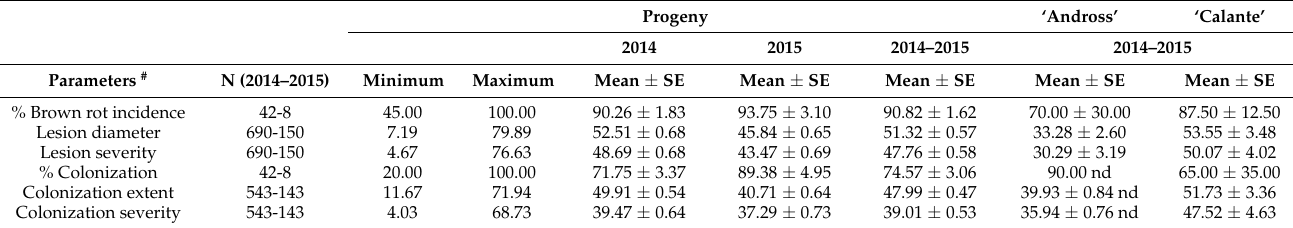
Table 3. Diseases parameters after inoculation with Monilinia laxa . N represents the number of the biological replications studied each year (2014–2015). Minimum, maximum, mean values ± standard error of all the progeny derived from ‘Andross’ × ‘Calante’ cross and both parents ‘Andross’ and ‘Calante’ evaluated in 2014 and 2015. Data of all genotypes presented in Table S1. For each genotype and trait, means are from N = 20 fruits. Progeny ‘Andross’ ‘Calante’